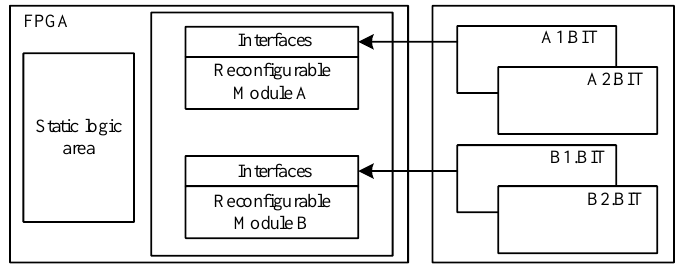
Figure 1. Concept of design for dynamic partial reconfiguration.